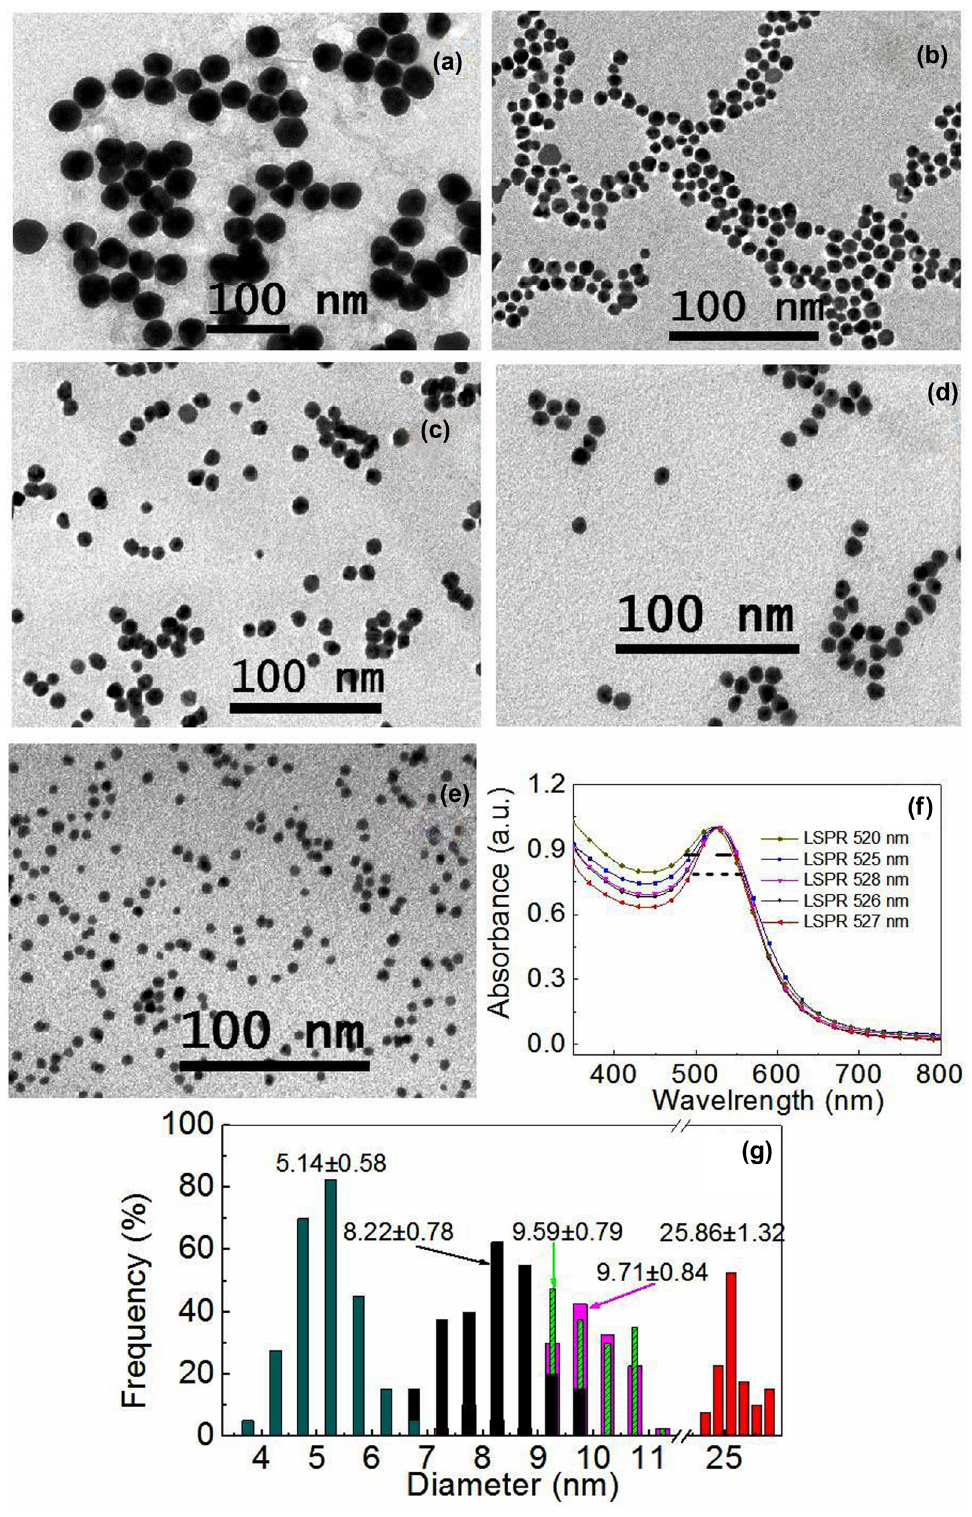
Figure 2: The TEM micrographs of Dex - AuNPs with di ff erent concentration of Dex ( 25, 100, 200, 500, and 1,000 μ L ) for ( a – e ) samples, respectively. ( f ) UV - Vis absorption spectra for the corresponding AuNPs [ 30 ] . ( g ) Particle size distributions of the TEM images; Copyright 2018,